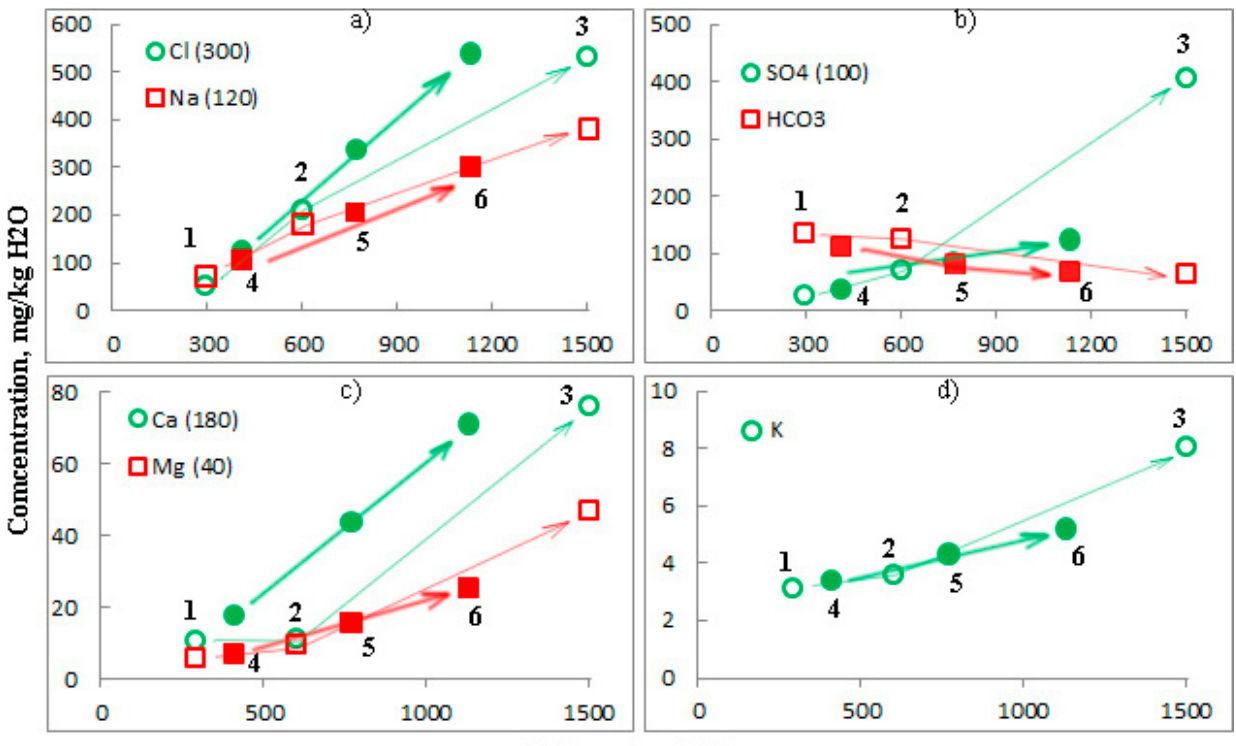
Figure 5. Dependence of changes in concentrations of main ions in obtained solutions: ( a ) Cl − and Na + ; ( b ) SO 42 − and HCO 3 − ; ( c ) Ca 2+ and Mg 2+ ; ( d ) K + according to Scenarios 1–3 (without filling marker) and 4–6 (complete filling marker) from their TDS values (see Tables 2 and 3). The concentrations of chlorine and sodium (Figure 5a), calcium and